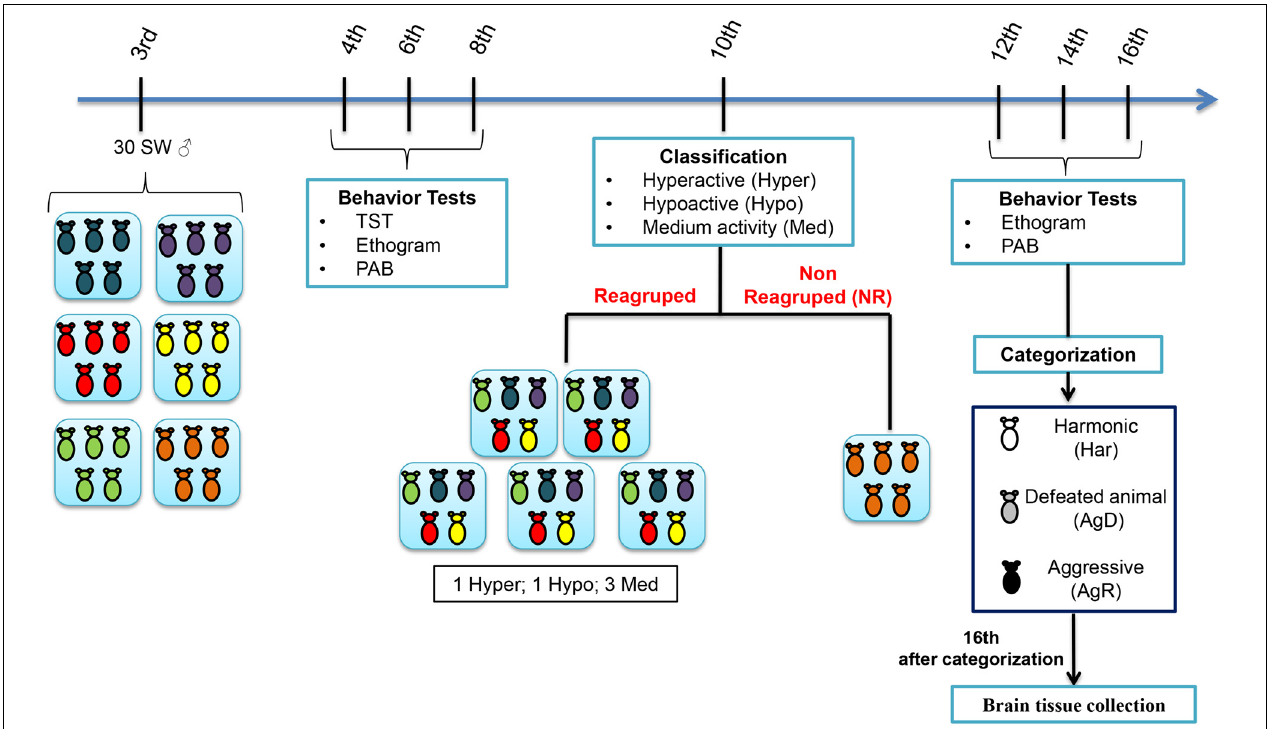
FIGURE 1 | Experimental design of the model of spontaneous aggression (MSA). Grouping of the male Swiss Webster mice was performed at the 3rd week of life in five groups ( n = 5 in each group) and behavioral tests such as the tail suspension test (TST), ethogram and pattern of aggressive behavior (PAB) test at the 4th, 6th, 8th weeks of life. At the 10th week of life, through mobility in the TST, they were classified as hyperactive (High), hypoactive (Low) and medium mobility (Med) and selected for regrouping. Some of the animals were regrouped in five groups with one High animal, one Low animal and three Med animals in each group. Regrouping represents a situation of social stress for animals. One group of 5 animals was not regrouped (NR); they were the social stress negative control. In the 12th, 14th, and 16th weeks of life, we performed the aggressive ethogram and the PAB test. In the 16th week of life, the regrouped animals were categorized as harmonic (Har), they were the social stress positive control, defeated animals (AgD) and highly aggressive (AgR). Then, the animals were euthanized, and the cerebral frontal cortices were removed for immunohistochemistry, dihydroethidium assay and Western blot